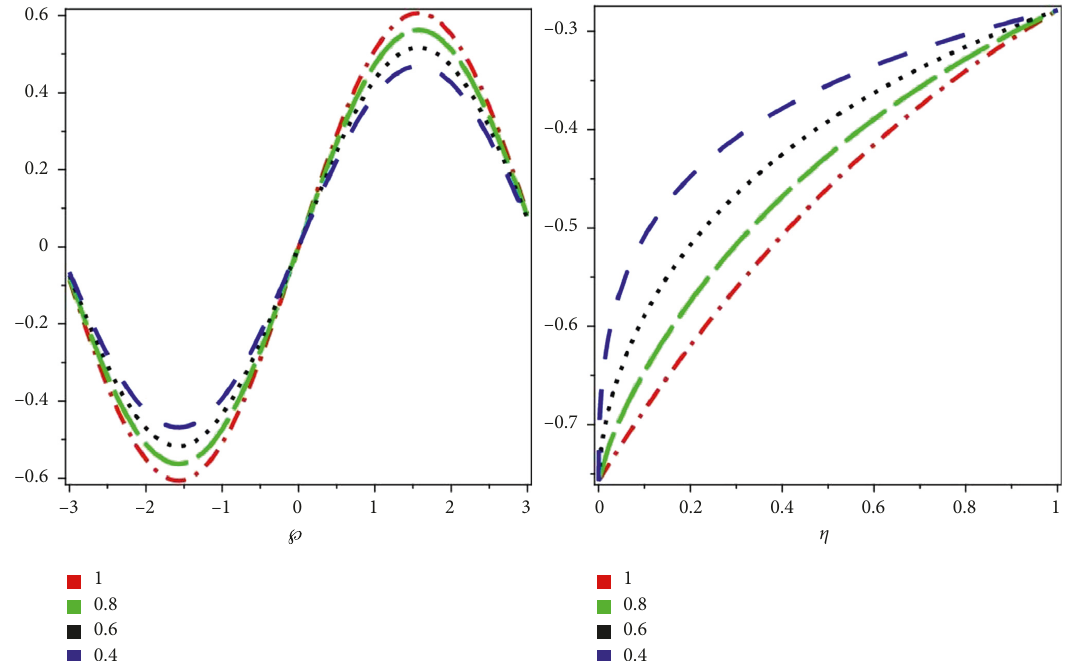
Figure 4: First figure show that the analytic result of various fractional-order of problem 4 and second graph with respect to time.